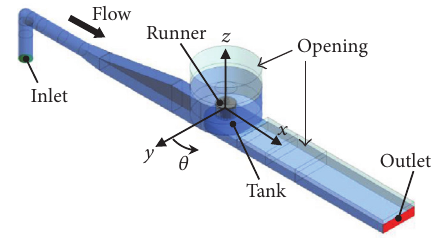
Figure 4: Definition of performance evaluation.